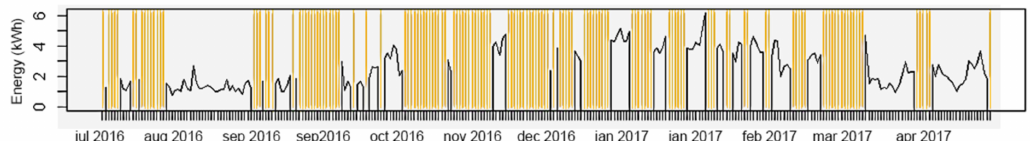
Figure 7. Example of installations labelled “Data